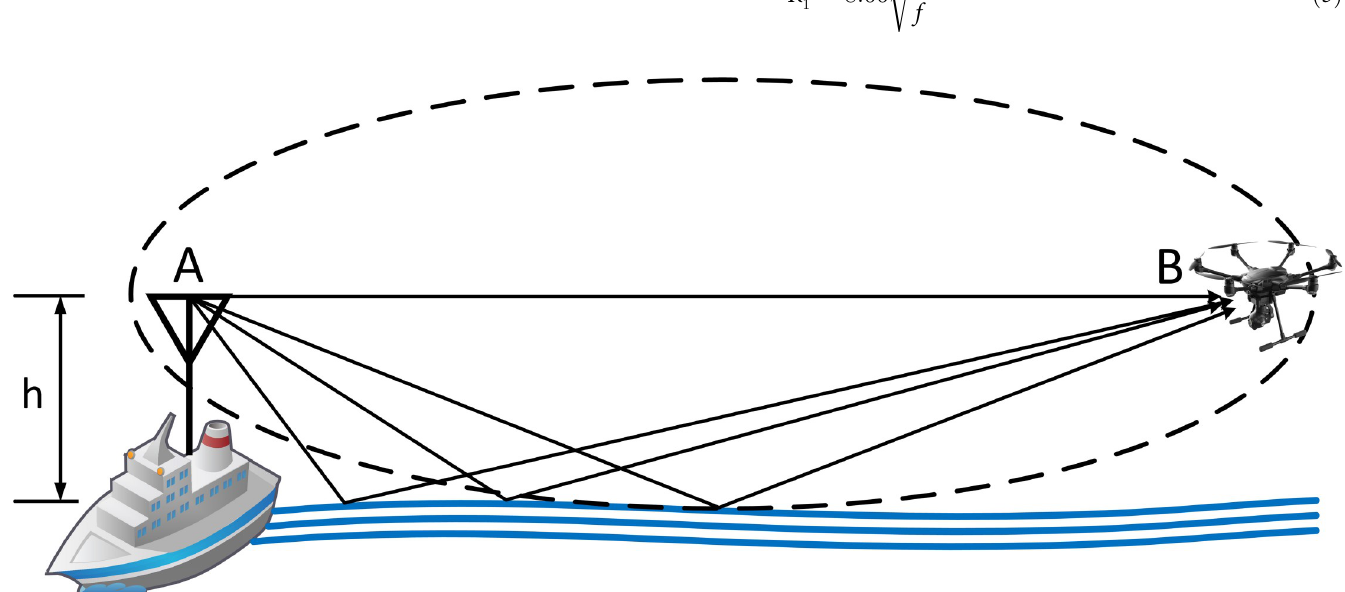
Fig 4. The two possible flight heights of the UAV and their influence on the clearance of the first Fresnel ellipsoid.